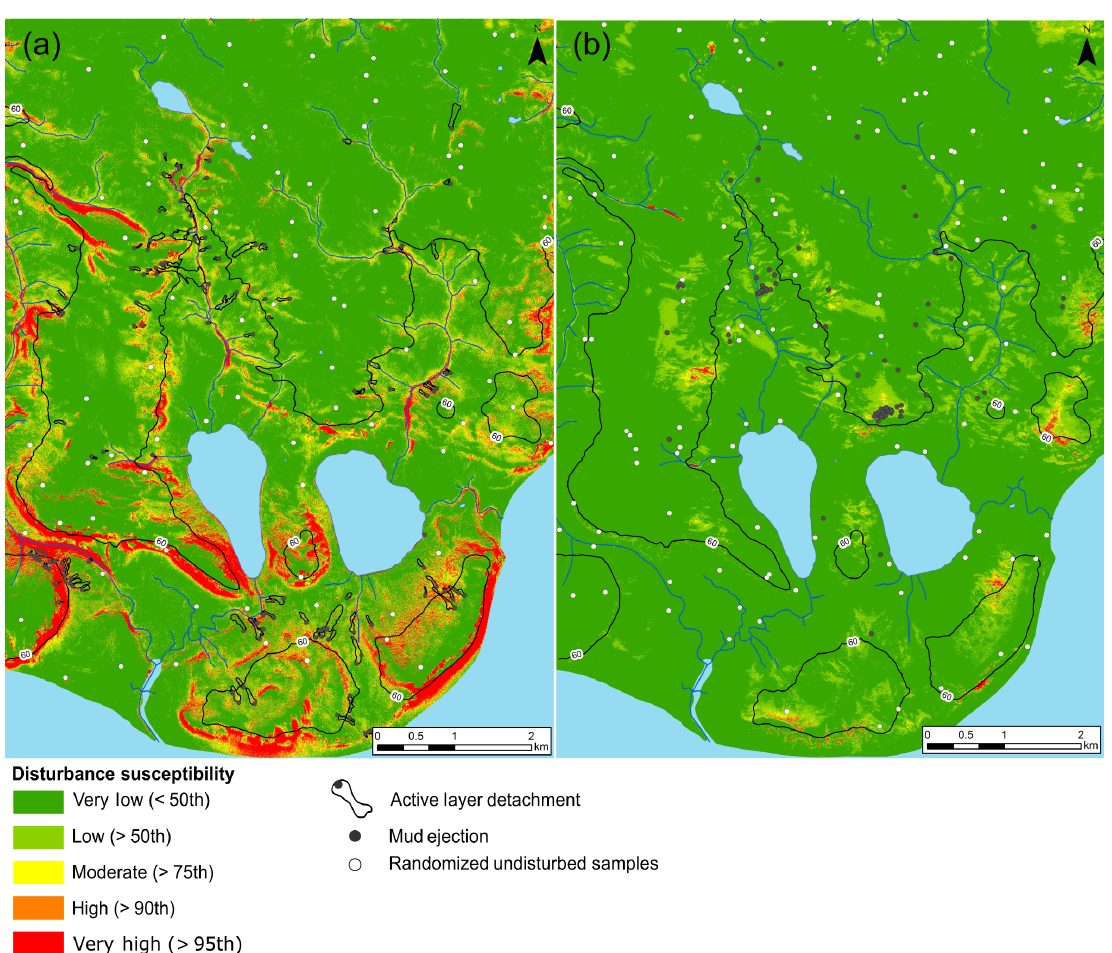
Figure 4. ALD (a) and ME (b) susceptibility maps for CBAWO showing areas of very low to very high susceptibility to disturbance. Marine limit is denoted by the 60m contour line, and the random points for undisturbed locations are indicated.